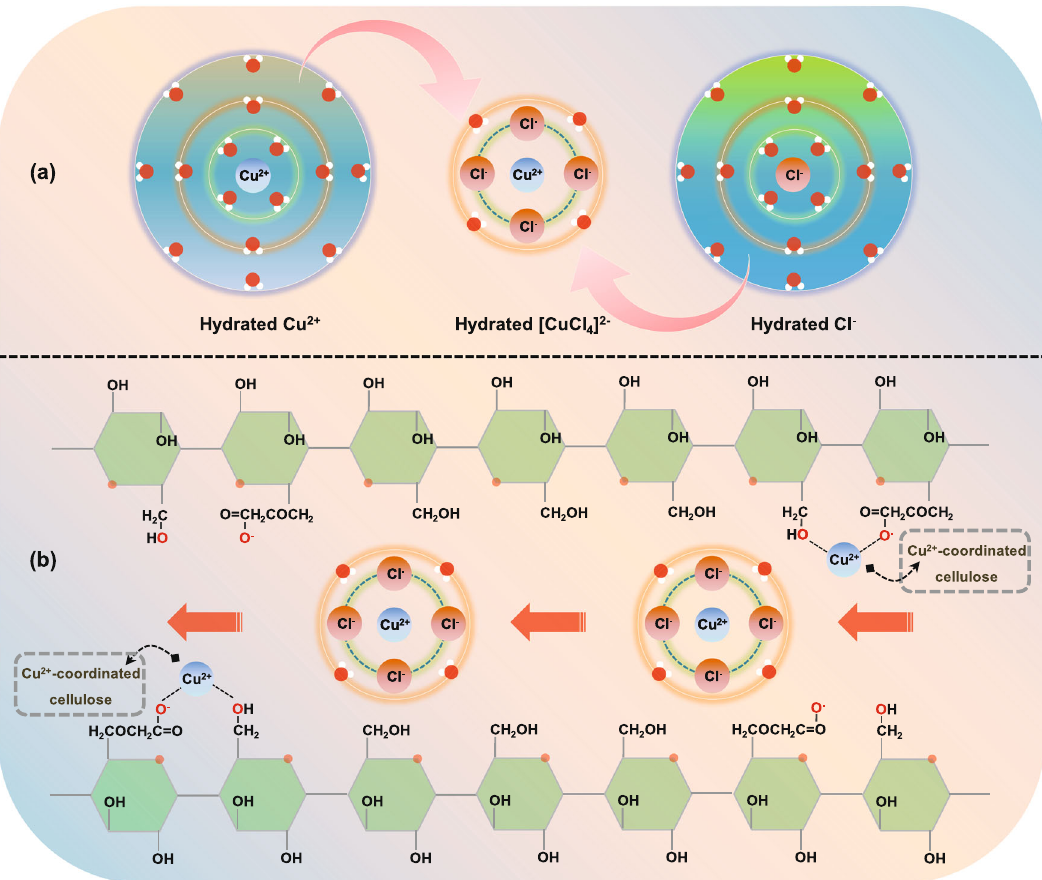
Fig. 1 Design principle for copper-coordinated cellulose ionic conductors. a Chemical con fi guration of hydrated ions (Cu 2 + , Cl − and [CuCl 4 ] 2 − ). b Synthesis of [CuCl 4 ] 2 − enhanced by carboxylated cellulose in CuCl 2 aqueous solution. Photo credit: Bin Chen, Department of Electrical and Electronic Engineering, Southern University of Science and